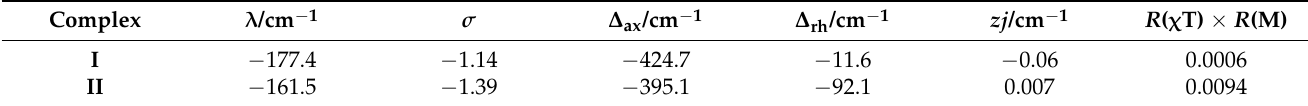
Table 1. Magnetic parameters extracted from optimum fit for complexes I and II .